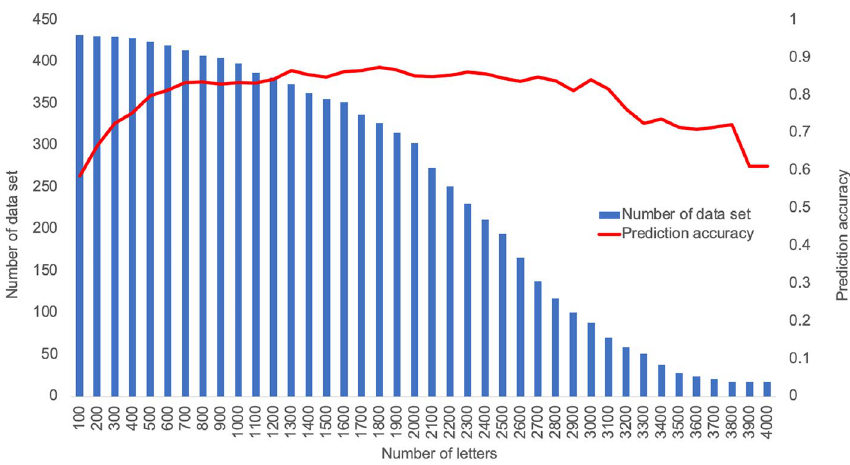
Figure 3. Relationship between number of letters and prediction accuracy of machine learning